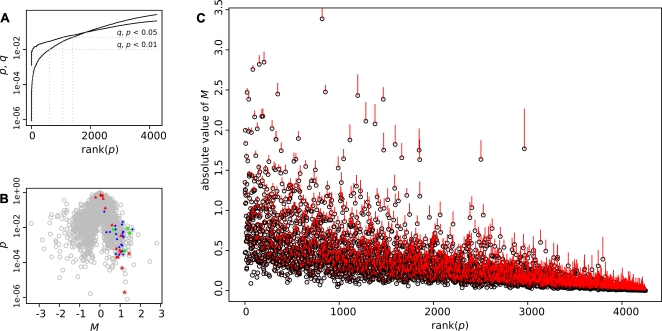
Statistical analysis of microarray results.A: q and p values ranked by p-values. B: Vulcano plot showing the p-values as a function of expression changes. Blue diamonds: genes from the Nduf family. Red triangles: genes from the Atp5 family. Green dots: genes from the Cox6 family. C: Absolute value of M ranked by increasing values of p. The red bars represent the standard deviation of M. Some genes have a low rank despite a strong M value, often because of their higher variability, as indicated by the length of their vertical bars.